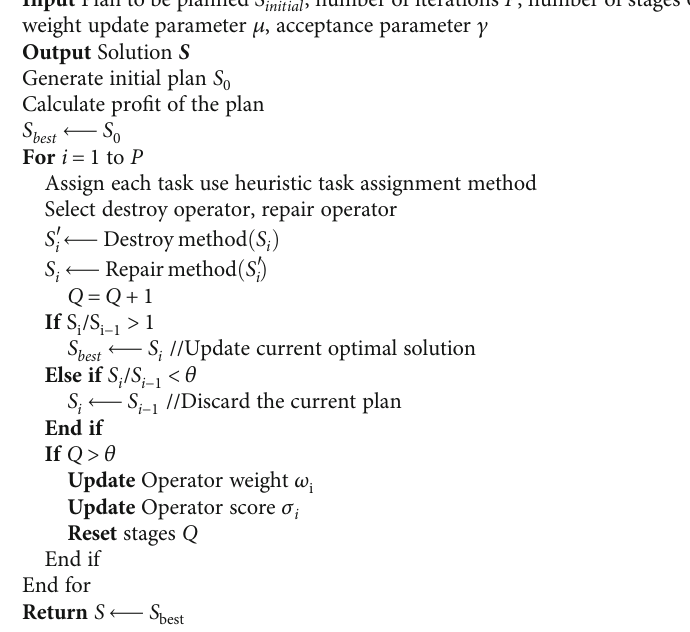
Algorithm 1: Heuristic adaptive large neighborhood search algorithm (H-ALNS)